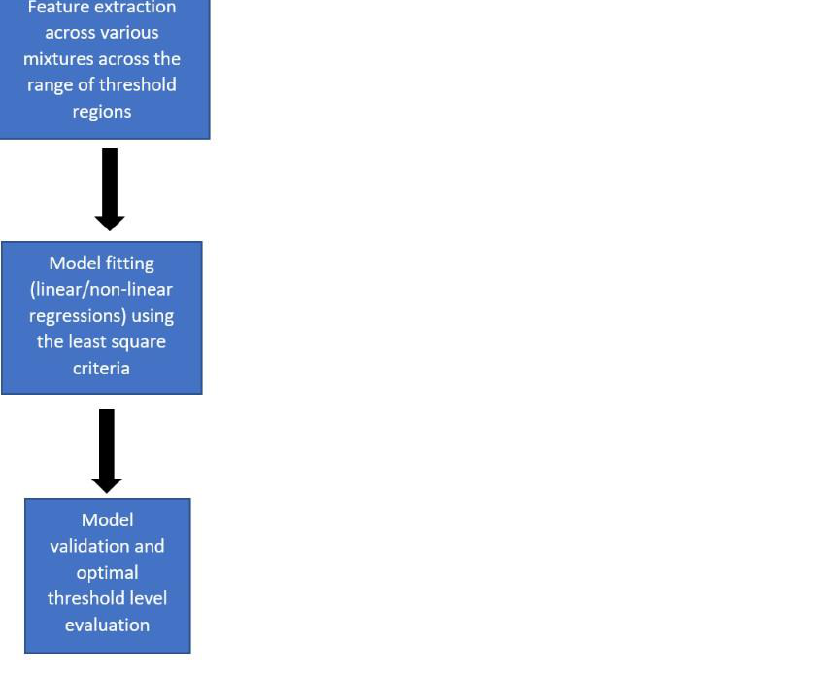
Figure 4. A flow diagram of the signal processing method for powder mixtures.